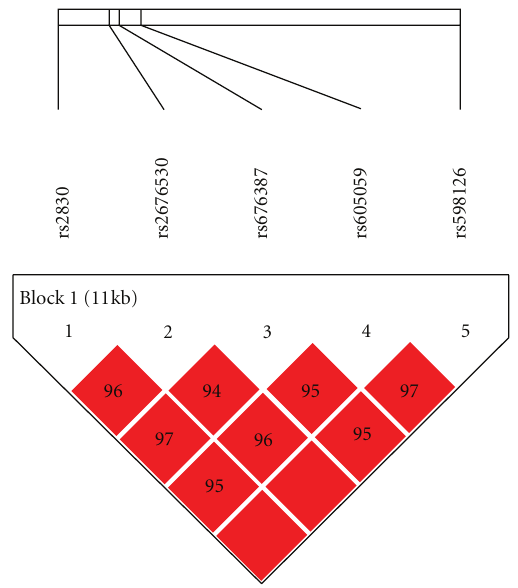
Figure 3: Linkage disequilibrium patterns for SNPs in HSD17B1 .